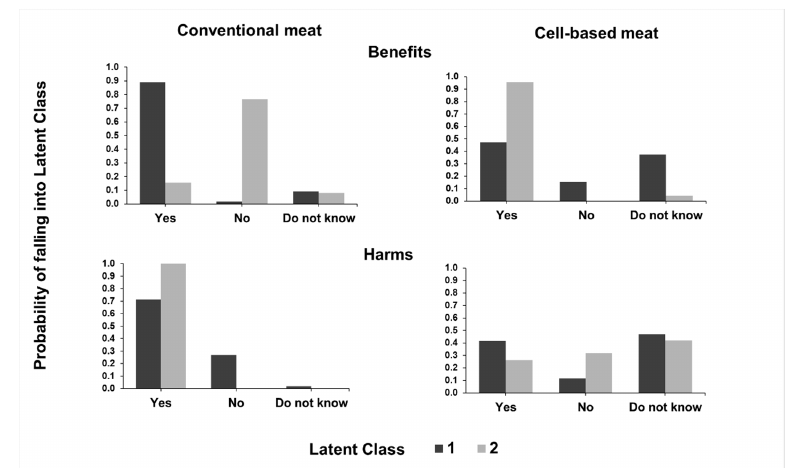
Figure 1. Benefits and harms of conventional and cell-based meat in each latent class according to 209 Brazilian veterinarians and 63 animal scientists responding to an online questionnaire. Latent Class 1 (217 respondents) presents a more proconventional perception, and LC 2 (55 respondents), a more pro-cell-based meat